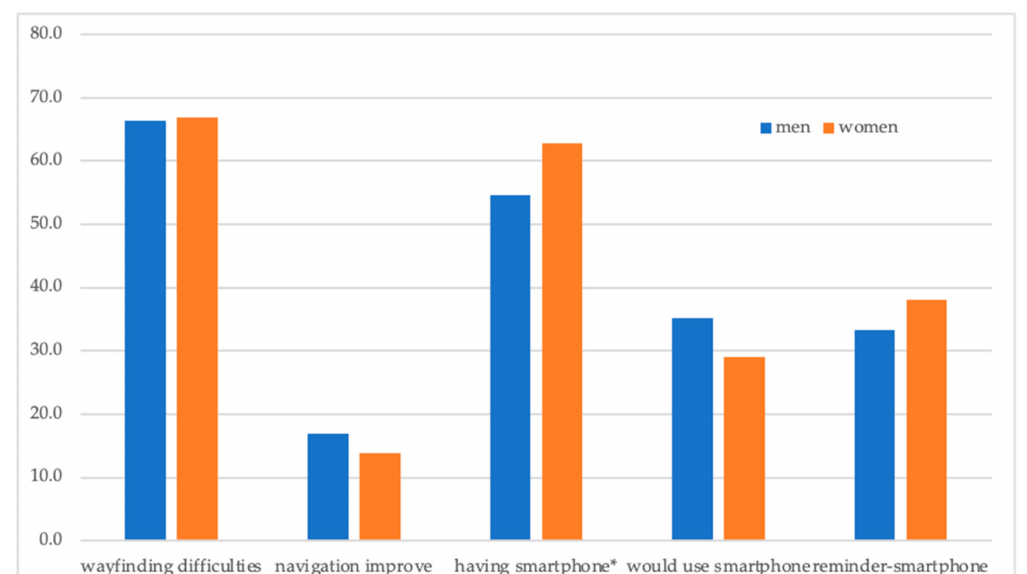
Figure 1. Gender and opinions of the respondents: share of positive answers (%). Source: The Authors. Note: variables significantly related to the gender are marked: * p < 0.05.